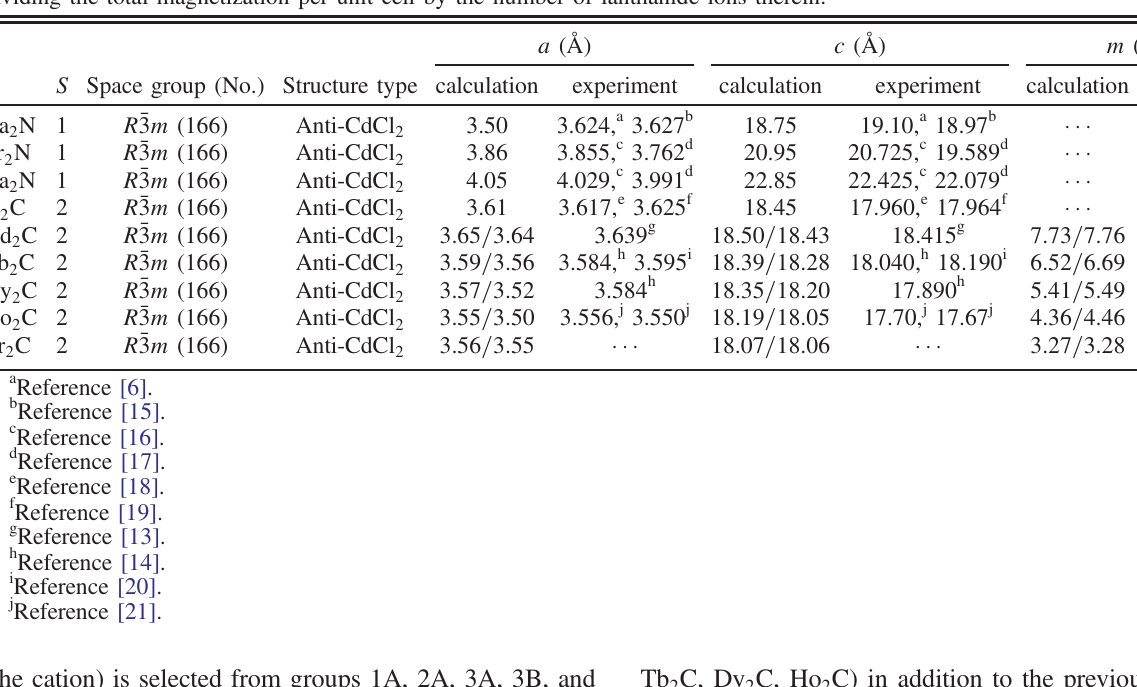
TABLE I. Materials satisfying all the screening conditions. Here, S denotes the sum of the oxidation numbers of the constituent elements in a primitive rhombohedral unit cell ( M 2 X ). The lattice constants (in the hexagonal setting) and magnetic moments per lanthanide ion obtained in the present calculation are compared with the experimental values. The values before and after a slash represent the values obtained with U − J ¼ 6 and 9 eV (with J fixed at 0.7 eV), respectively. The magnetic moment m is obtained by dividing the total magnetization per unit cell by the number of lanthanide ions therein.